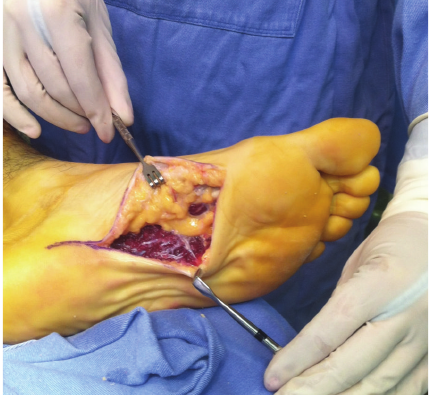
Figure 7: The final step after removing the plantar fascia.